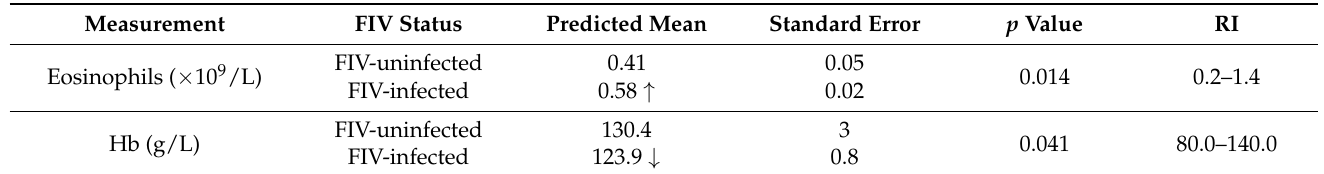
Figure 2. Hematology and blood biochemistry results in cohort 2 ( n = 282; external hematology and blood biochemistry testing) from 13 of 39 measurements that were significantly different between FIV-infected and FIV-uninfected cats. Reference intervals are shown as vertical dashed red lines. HCT = hematocrit, RBC = red blood cell count, A:G ratio = albumin:globulin ratio, ALP = alkaline phosphatase, AST = aspartate aminotransferase, GGT = gamma glutamyl transferase, TT4 = thyroxine. Table 6. Comparison of hematology results for cats in cohort 3 ( n = 425; FIV vaccine efficacy study). Only significant differences are shown (2 out of a total of 13 measurements analysed), with up ( ↑ ) and down ( ↓ ) arrows signifying significantly different mean values in FIV-infected cats compared to FIV-uninfected cats. Only absolute WBC counts (i.e., not relative WBC counts) were evaluated. RI = reference interval, Hb =